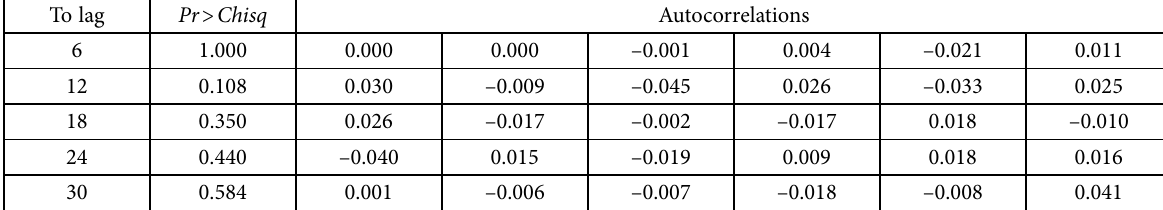
Table 4. Autocorrelation check for white noise for the 5-min ARIMA model at Site A